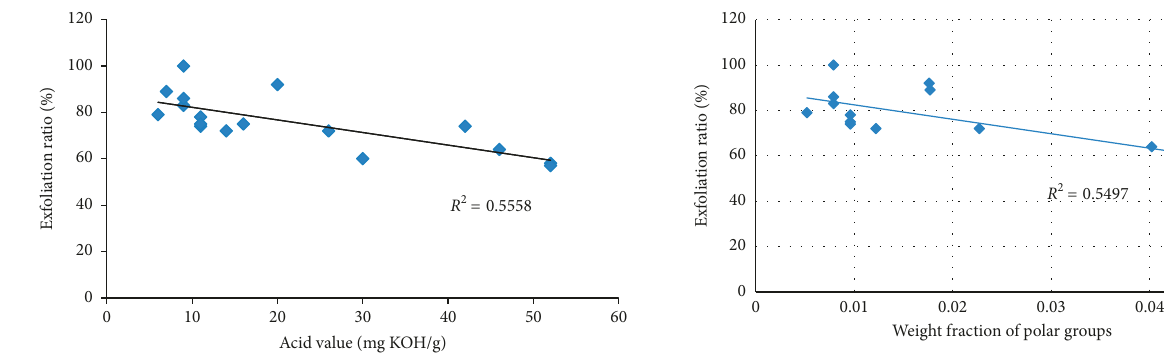
Figure 1: Nanoclay exfoliation ratio as a function of the com- patibilizer acid value.